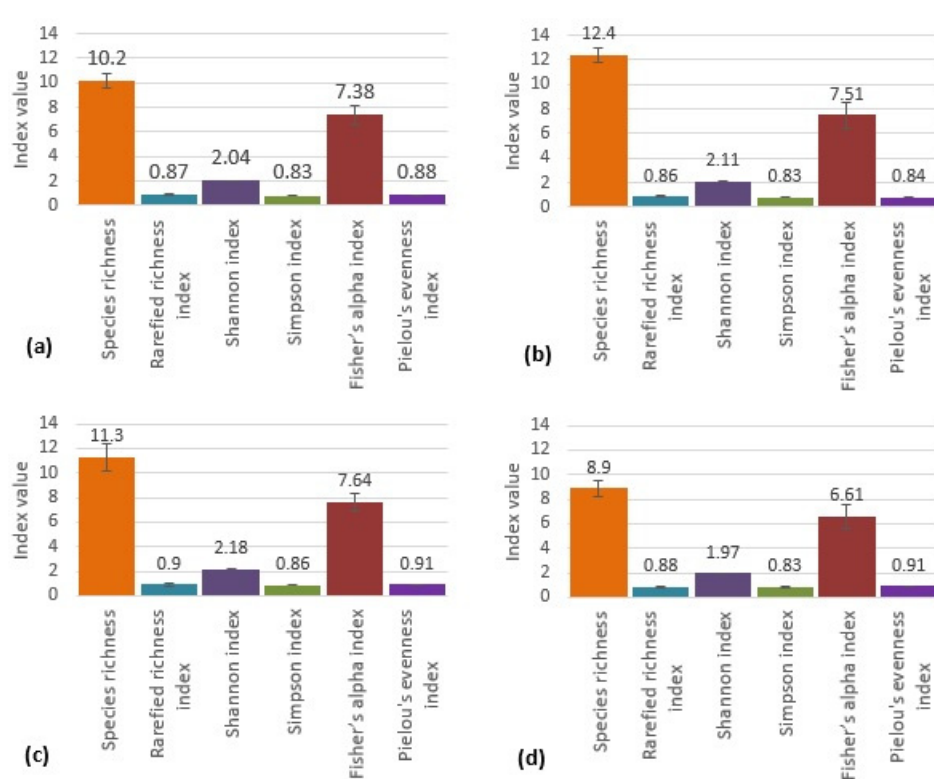
Fig. 6: Species richness, rarefied richness, Shannon index, Simpson index, Fisher’s alpha, and evenness in the peat depths of <50 cm (a), 393-<479 cm (b), 479-<565 cm (c), and ≥565 cm (d) (error bars represent std. errors of means).